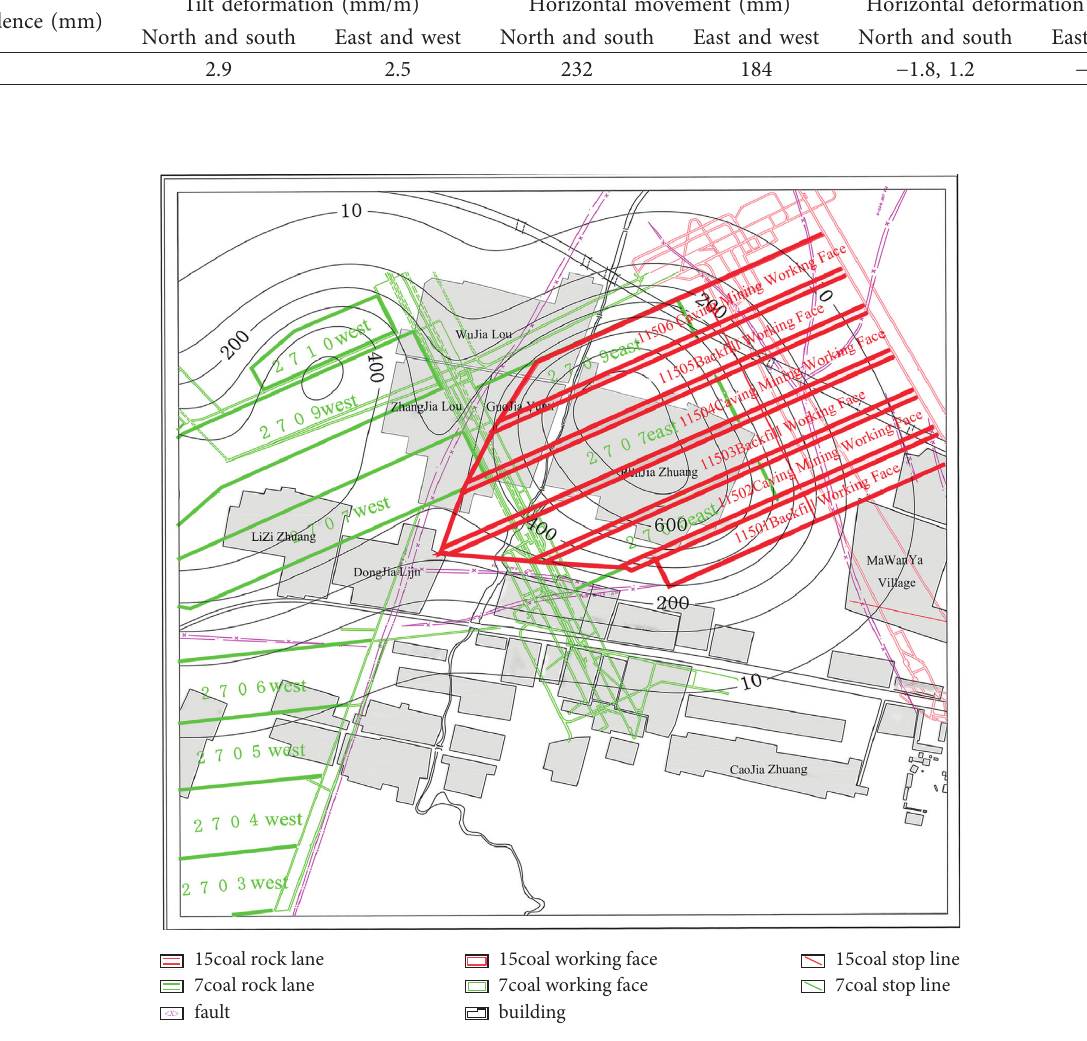
Figure 10: Contour map of surface